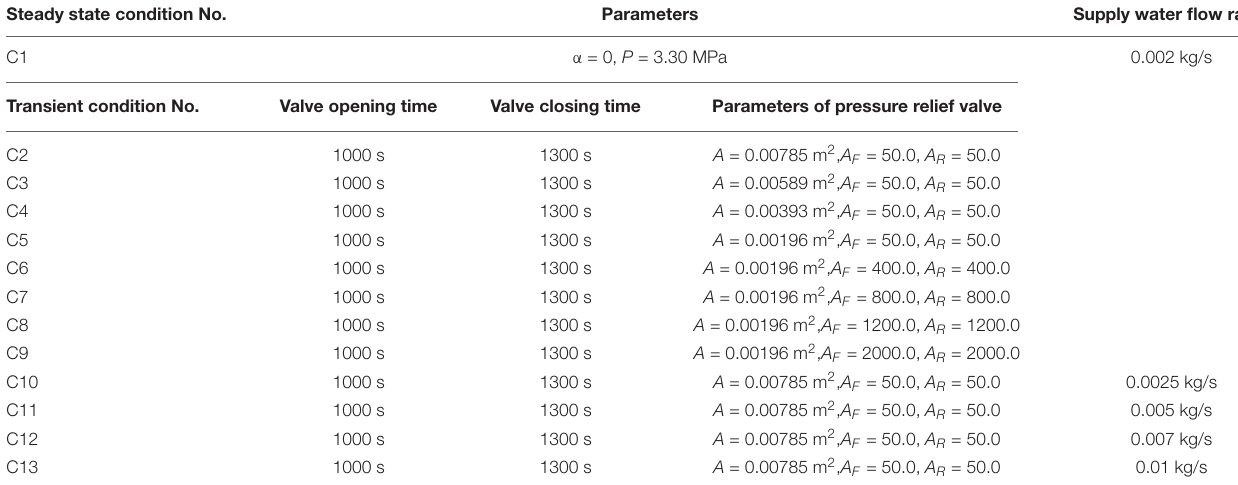
TABLE 2 | Calculation condition parameters. Steady state condition No.